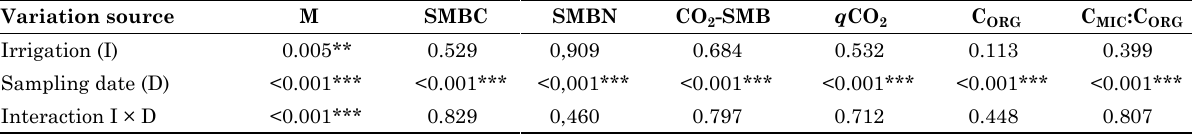
Table 2. Analysis of variance of soil gravimetric moisture (M), soil microbial biomass carbon and nitrogen (SMBC and SMBN), soil microbial biomass basal respiration (CO 2 -SMB), metabolic quotient ( q CO 2 ), organic carbon (C ORG ), and microbial carbon/organic carbon ratio (C MIC :C ORG ) in a 15-year-old secondary forest in eastern Amazonia